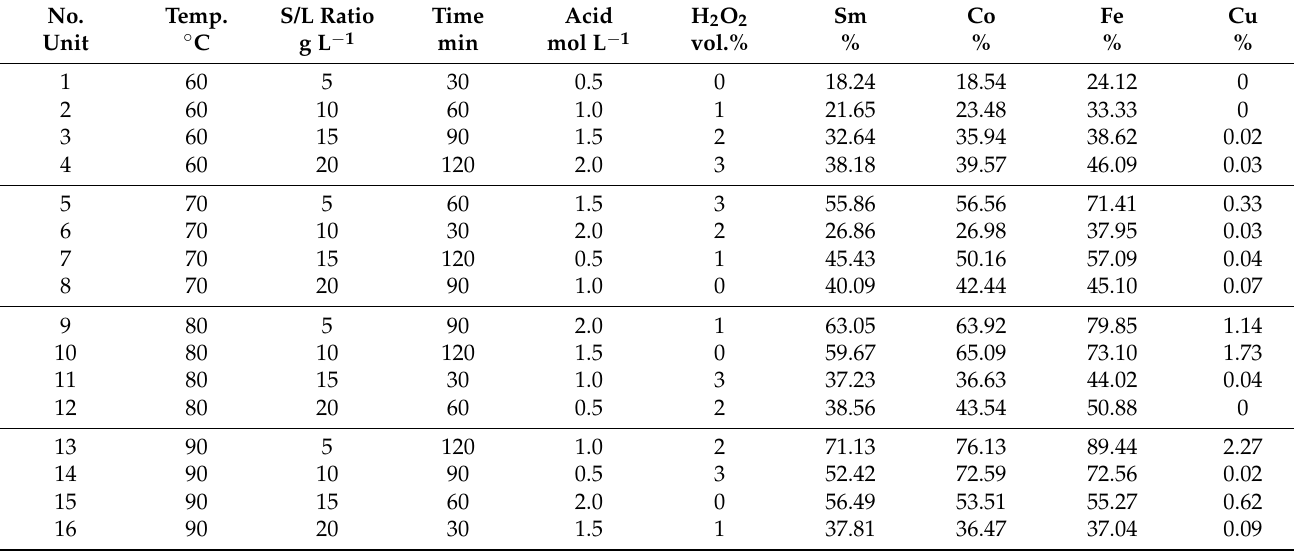
Table 4. Malic acid leaching rates of Sm, Co, Fe, and Cu under different control factors.